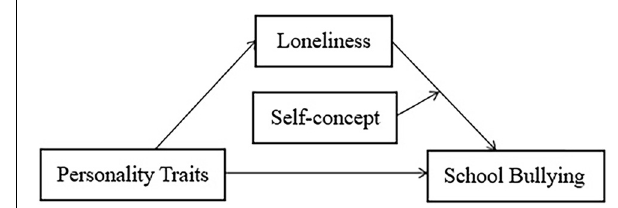
FIGURE 1 | The moderated mediating